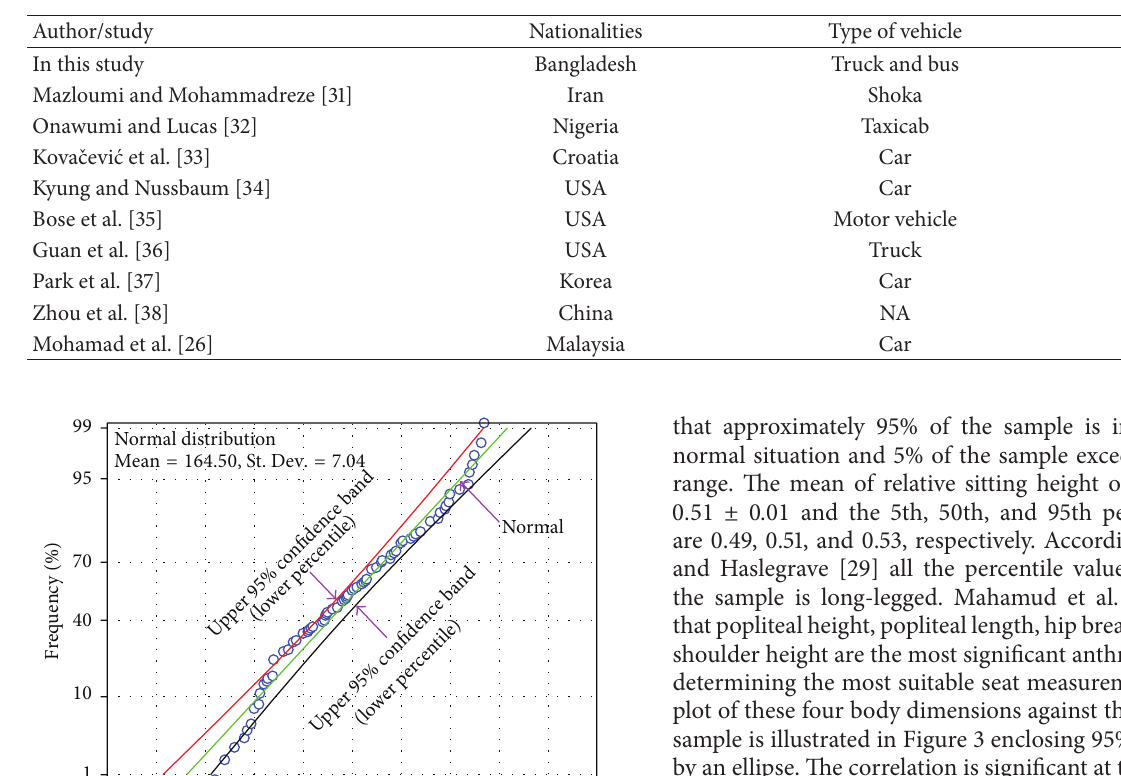
Table 2: Stature dimension of driver for different countries.